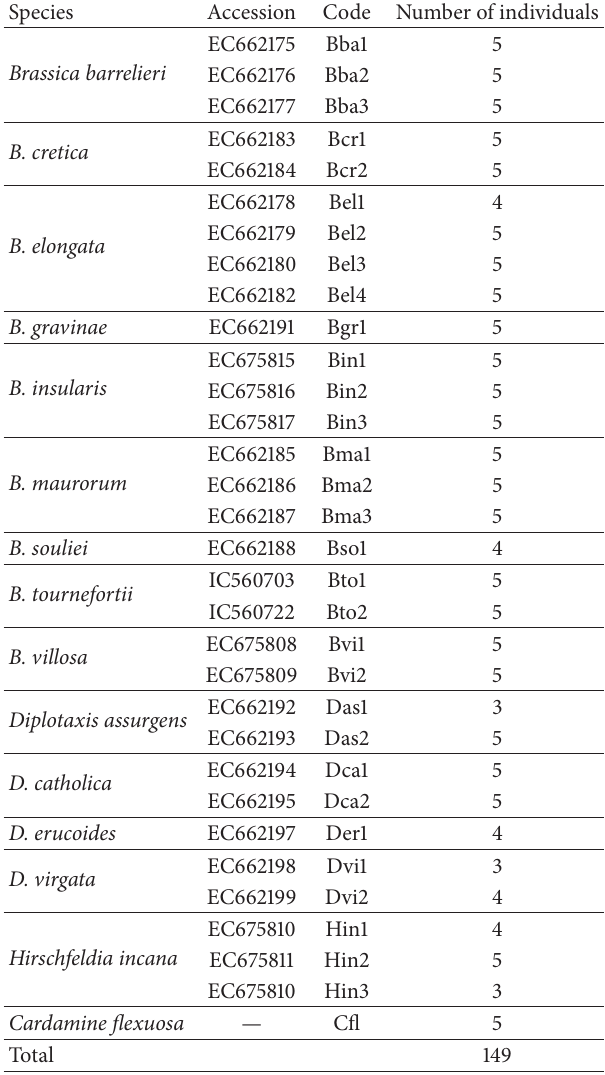
Table 1: List of species with accessions, code, and the number of individuals used in the